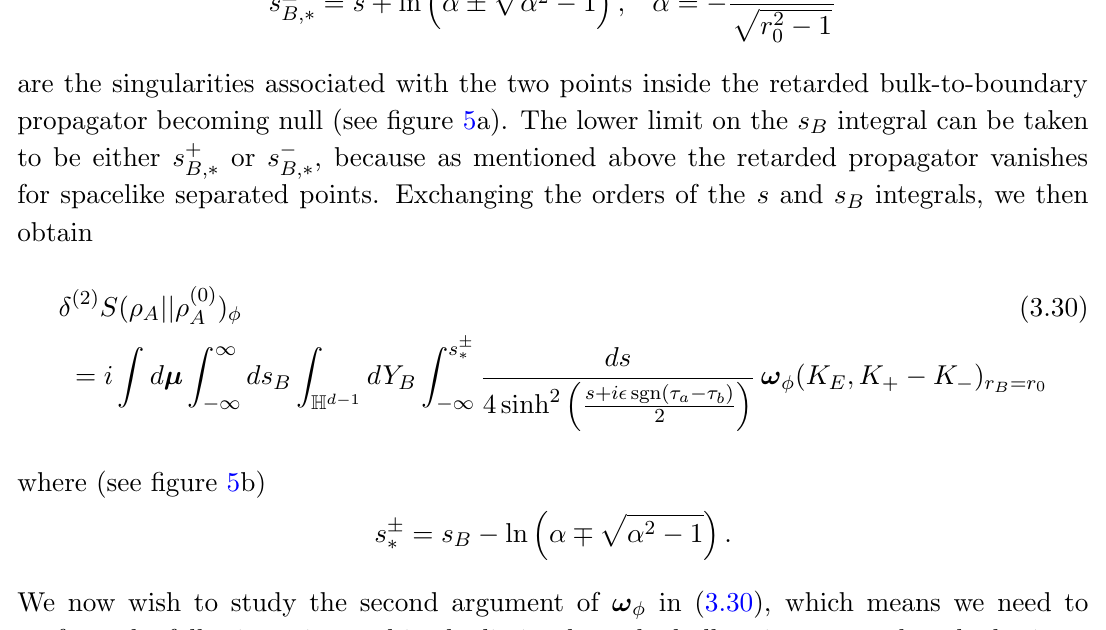
Figure 5 . The null singularities of the Wightman propagators. (a) The s blue portion; the dashed blue line is the spacelike region which we can include for free. (b) The s integral is over the blue portion, and once again we can include the dashed blue portion for